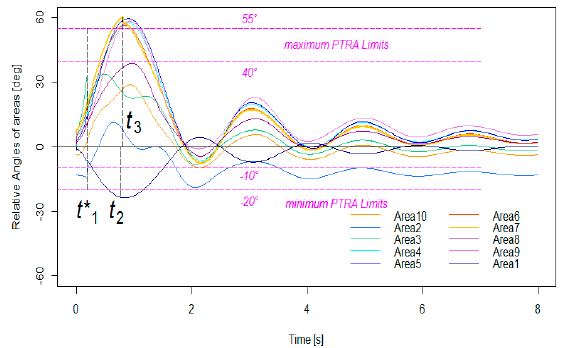
Figure 8. Relative oscillation of the power system for a three-phase fault in Line 4-5 cleared at 0.19 s and with some control actions applied.